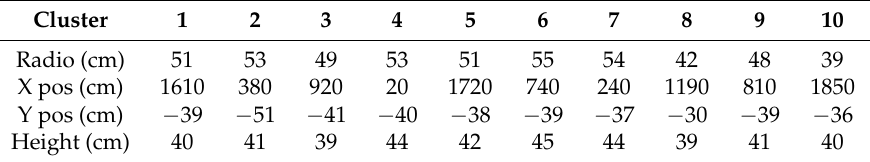
Table 2. Centers, radios and height obtained from Figure 6e.